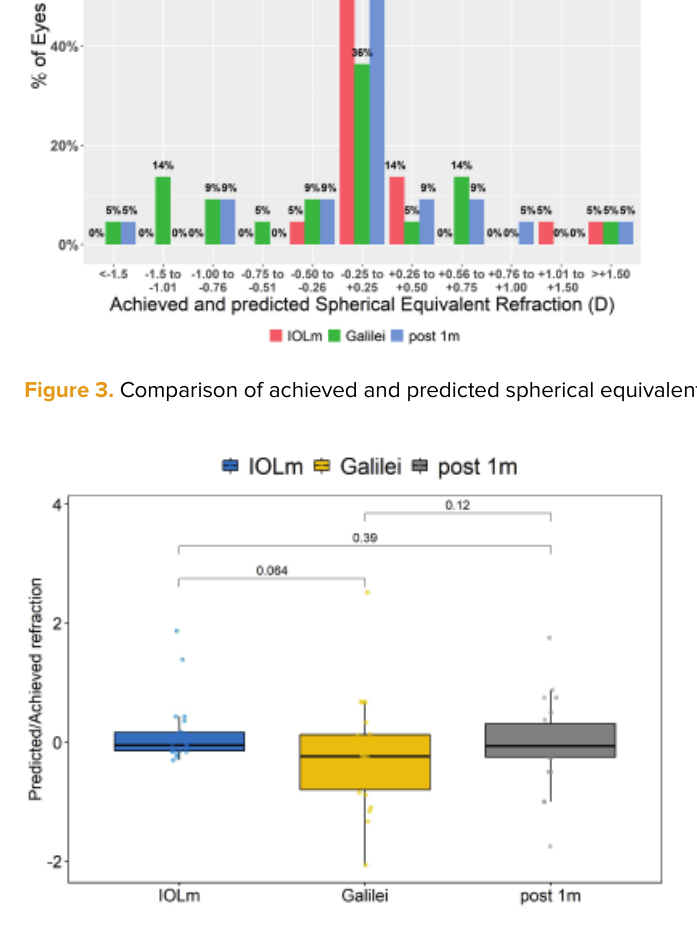
Figure 4. The quotient of the predicted and achieved refraction is